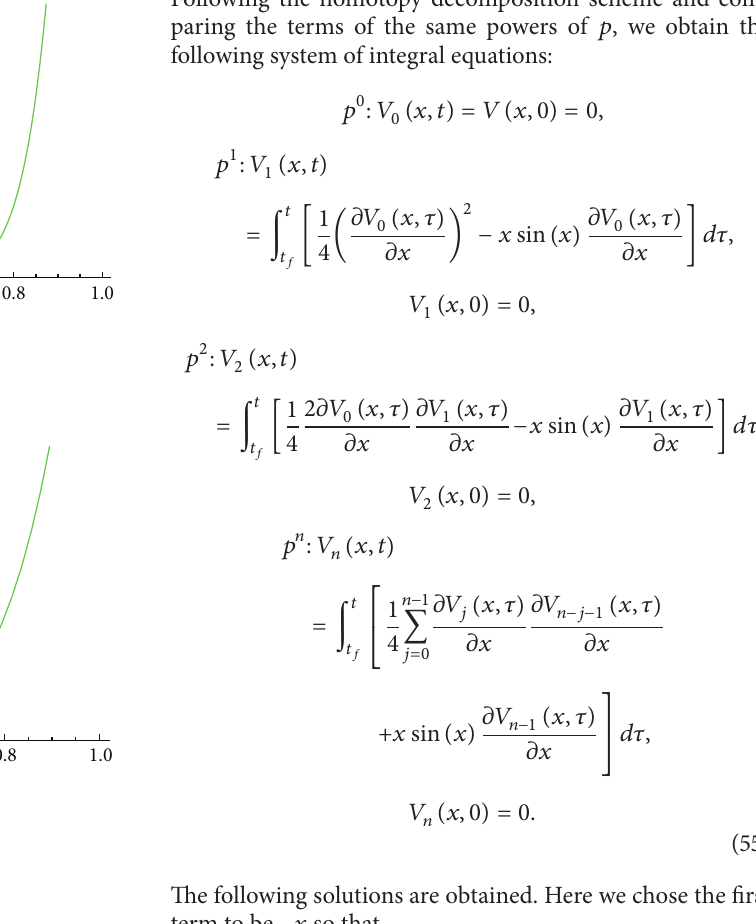
Figure 3: Numerical error.